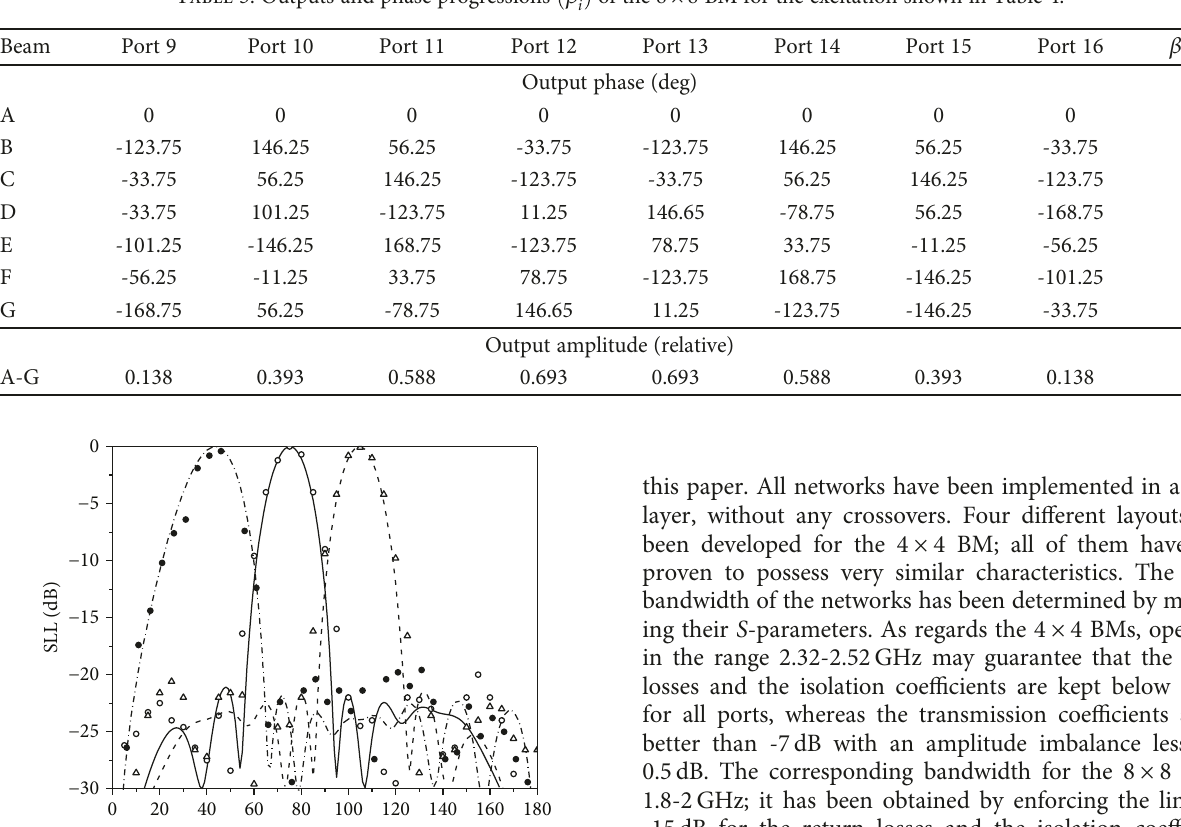
Table 4: Inputs of the 8 × 8 BM in order to produce the radiation patterns of Figure 14. ( φ Beam